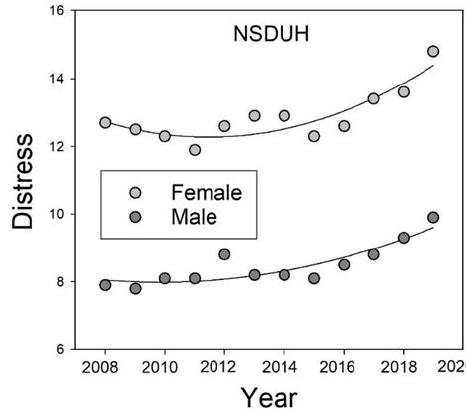
Figure 3. Percentages of females and males reporting serious psychological distress in the past year on the NSDUH surveys from 2008 to 2019.